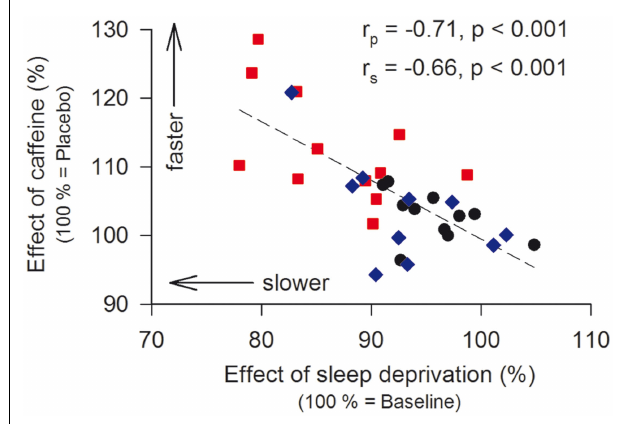
FIGURE 5 | Relationship between the effects of sleep deprivation and caffeine on the 10th percentile of speed (optimal performance) on the psychomotor vigilance task (PVT). To quantify the effect of sleep deprivation, the 10th percentile after sleep deprivation in the placebo condition was expressed as a percentage of the corresponding baseline value.To quantify the effect of caffeine, the 10th percentile after sleep deprivation in the caffeine condition was expressed as a percentage of the corresponding value in the placebo condition. Data are plotted on a linear scale. Black dots: aged individuals; blue diamonds: caffeine-insensitive individuals; red squares: caffeine-sensitive individuals. A linear regression line was fitted through 32 individual data points. r p : Pearson’s product-moment correlation coefficient, r s : Spearman rank correlation coefficient.